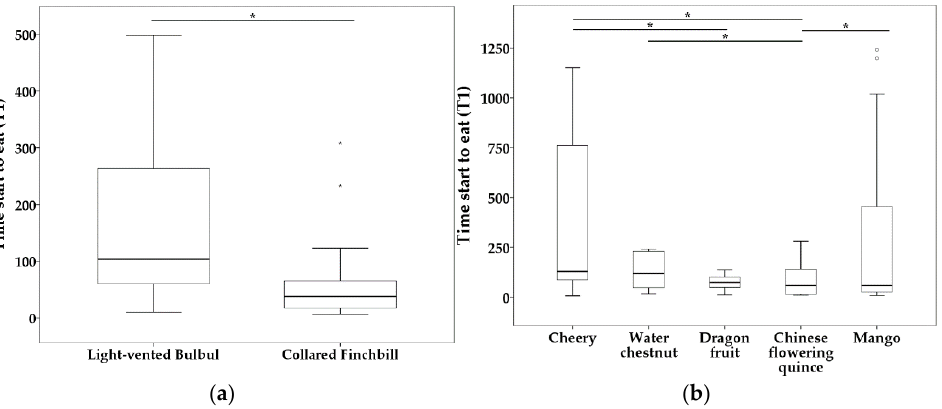
Figure 2. Boxplots of influence of species ( a ) and novel food type ( b ) on time to start eating novel food (t1). Bars show the maximum observed value (upper part) and the minimum observed value (lower part). Line and asterisk(s) above the boxplots indicate statistically significant comparisons between the two groups. Upper edge of the box shows the upper quartiles (Q3), while the lower edge of the box shows the lower quartiles (Q1). The middle line in the box shows the median. Abnormal values are shown as small circles for outliers and asterisk for extrema above the boxplots but under the line. * p < 0.05. eating during 30 min (DP) ( df = 4, F = 2.944, p = 0.025). Novel food Chinese flowering quince (type d) was eaten for shorter time duration than both cherry (type a) and water chestnut (type b) during 30 min (Table 3), while water chestnut (type b) was eaten for longer time duration than mango (type e) during 30 min (Table 3, Figure 3). However, the main effects ‘sex’, ‘species’ , and ‘social context’ were not significant (sex: df = 1, F = 0.244, p = 0.623; species: df = 1, F = 0.095, p = 0.759; social context: df = 1, F = 2.048, p = 0.156). Also, the sex × social context and species × social context interactions were not significant (sex × social context: df = 1, F = 0.157, p = 0.693; species × social context: df = 1, F = 0.127, p = 0.722). Table 3. Effects of fixed factors on percentage of time eating during 30 min (DP) for solitary and group Light-vented Bulbuls and Collared Finchbills. Fixed Effect